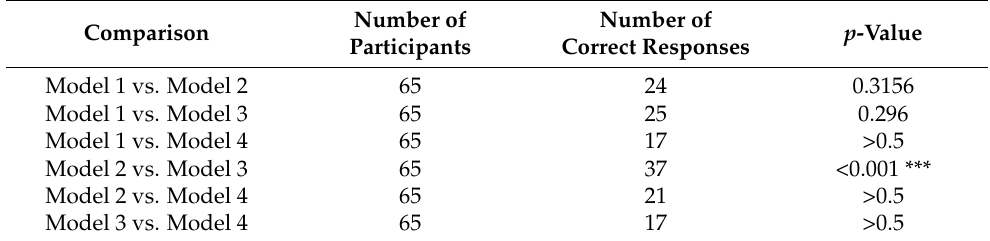
Table 3. Triangle Test results for the models with different Rose oxide ratios, performed by z-test (n = 65, for all tests) a .